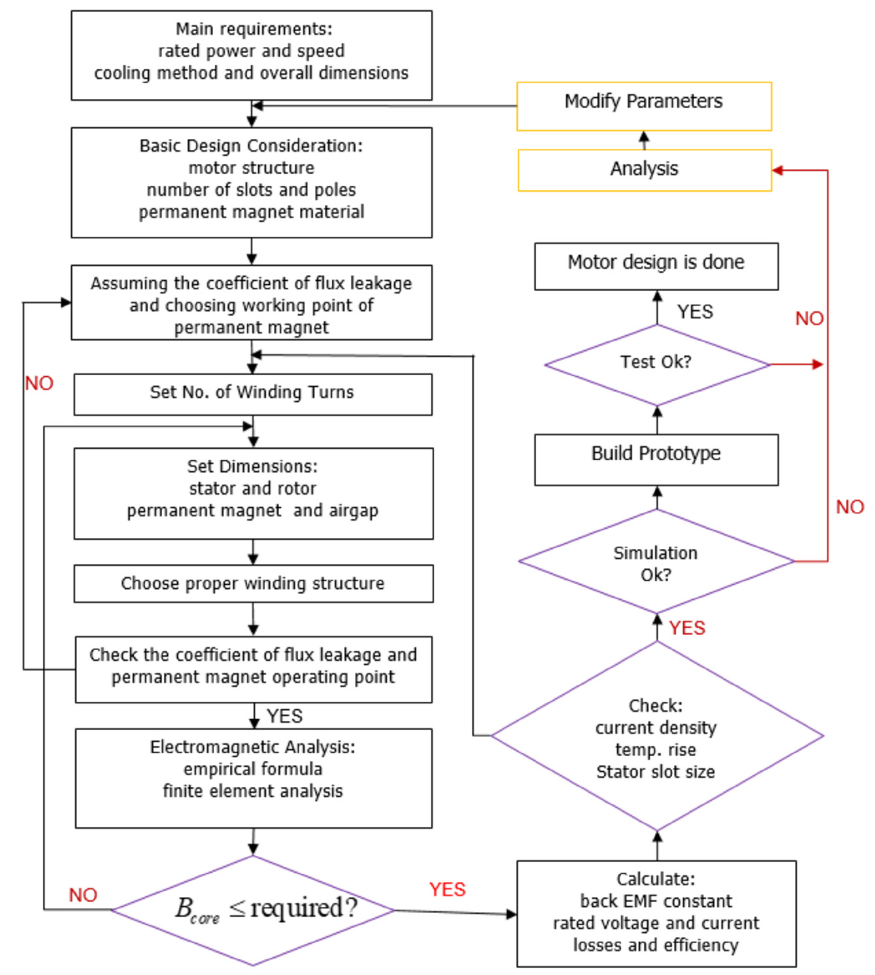
Figure 1. Brushless DC motor design